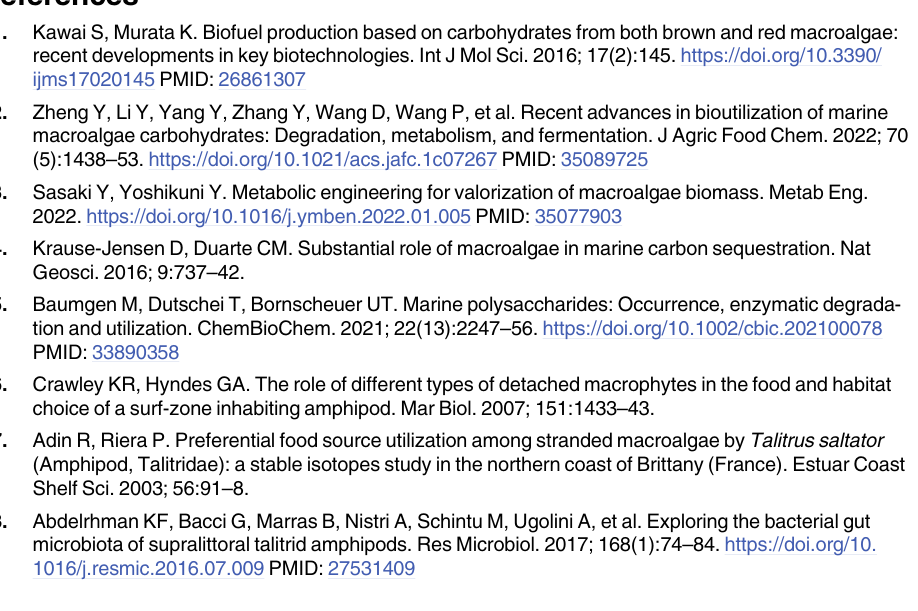
S1 Table. Frequency of the genera of bacteria in each sample. S2 Table. Frequency of the genera of fungi in each sample. S3 Table. Cellobiohydrolase homologs found in